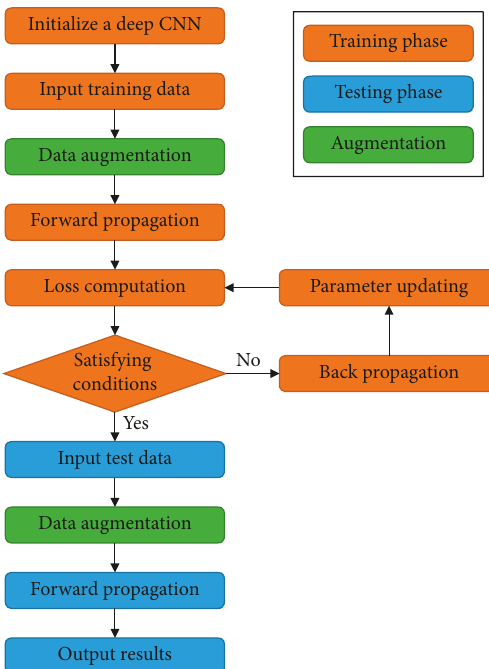
Figure 1: The overall flow of training and testing of deep